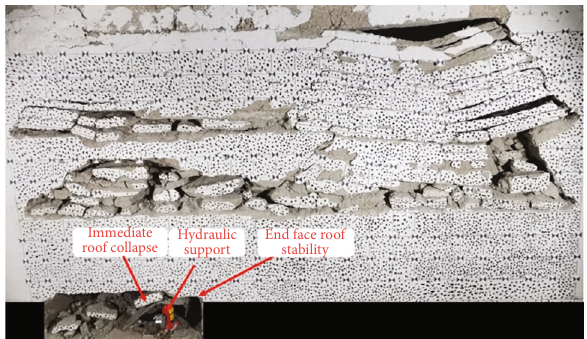
Figure 8: Roof state of immediate roof